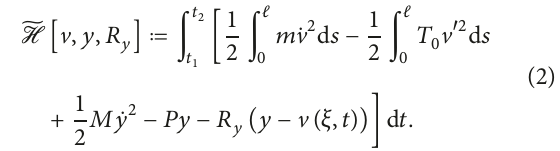
Figure 1: Horizontal taut string travelled by a heavy point